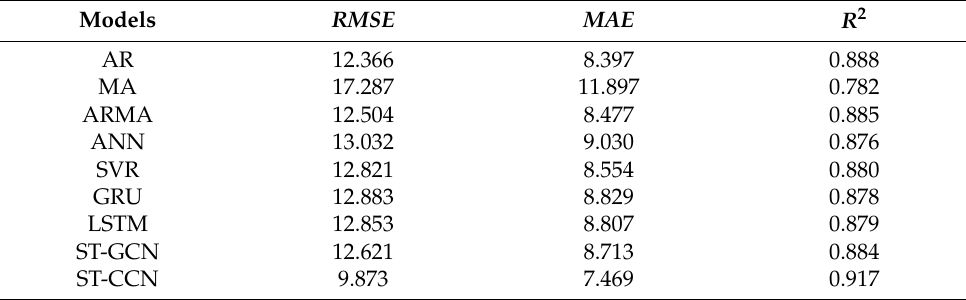
Table 3. Performance Comparison of each model (single station,